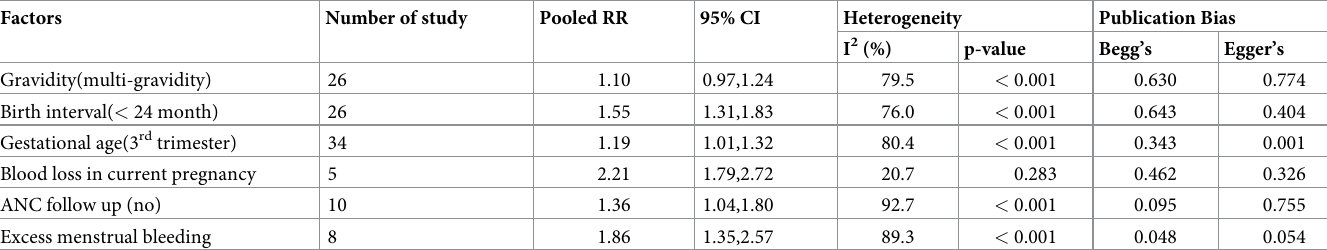
Table 4. Association of obstetric history and anemia among pregnant women in Ethiopia.